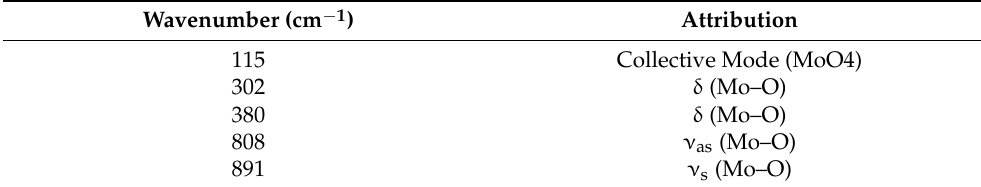
Table 3. Assignments of the Raman bands of sodium molybdate.